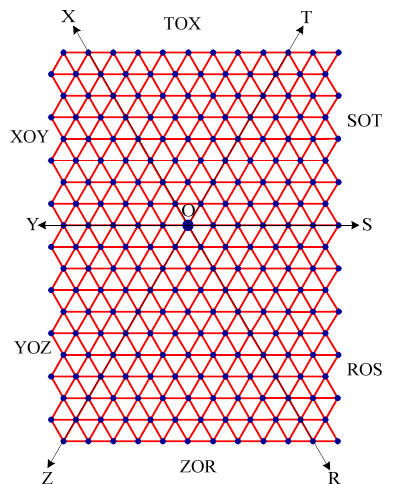
Figure 11. The rectangular sheet is divided into 6 zones: zones ROS, SOT, TOX, XOY, YOZ and ZOR.